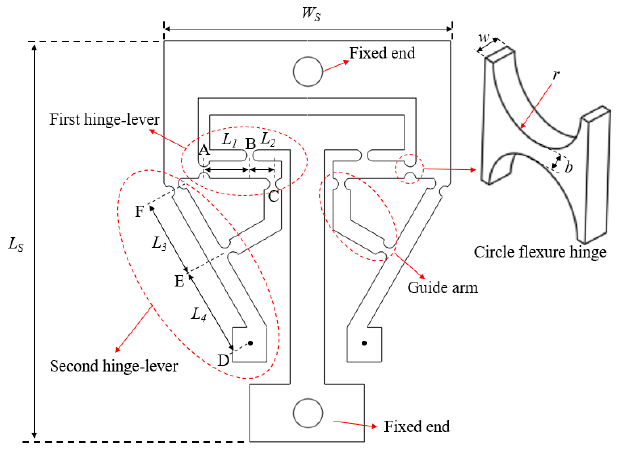
Figure 2. The proposed sensitization structure and assembly diagram.